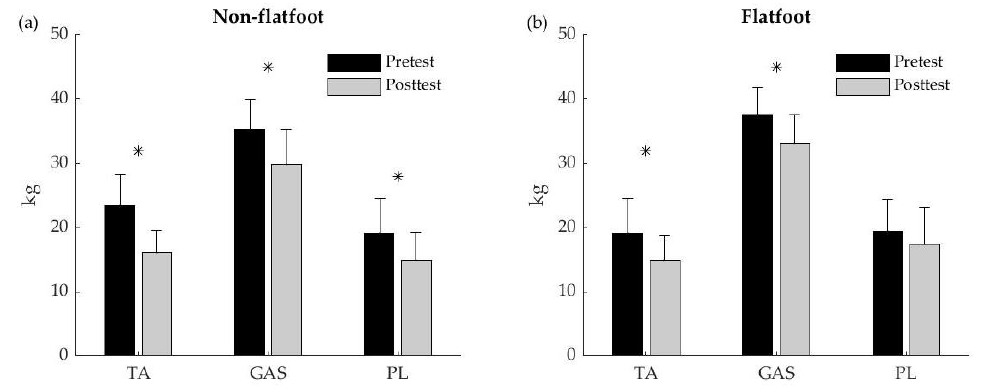
Figure 3. Maximal muscle strength of ( a ) non-flatfoot and ( b ) flatfoot groups. * Significant differences between pretest and posttest. TA, tibialis anterior; GAS, gastrocnemius; PL, peroneus longus.